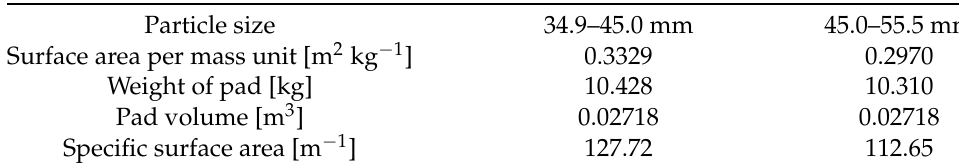
Table A2. Summary of data used to compute the specific surface area of pads built with pumice stone material.